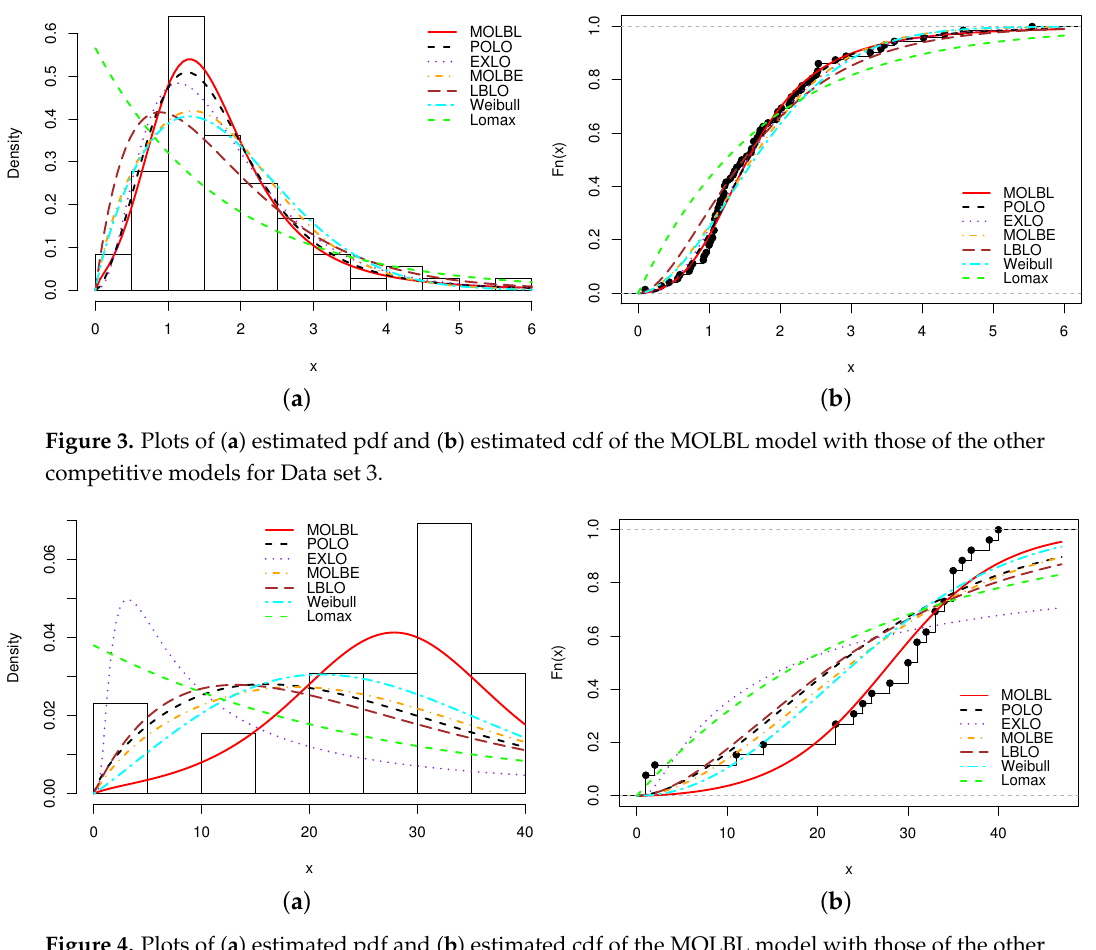
Figure 4. Plots of ( a ) estimated pdf and ( b ) estimated cdf of the MOLBL model with those of the other competitive models for Data set